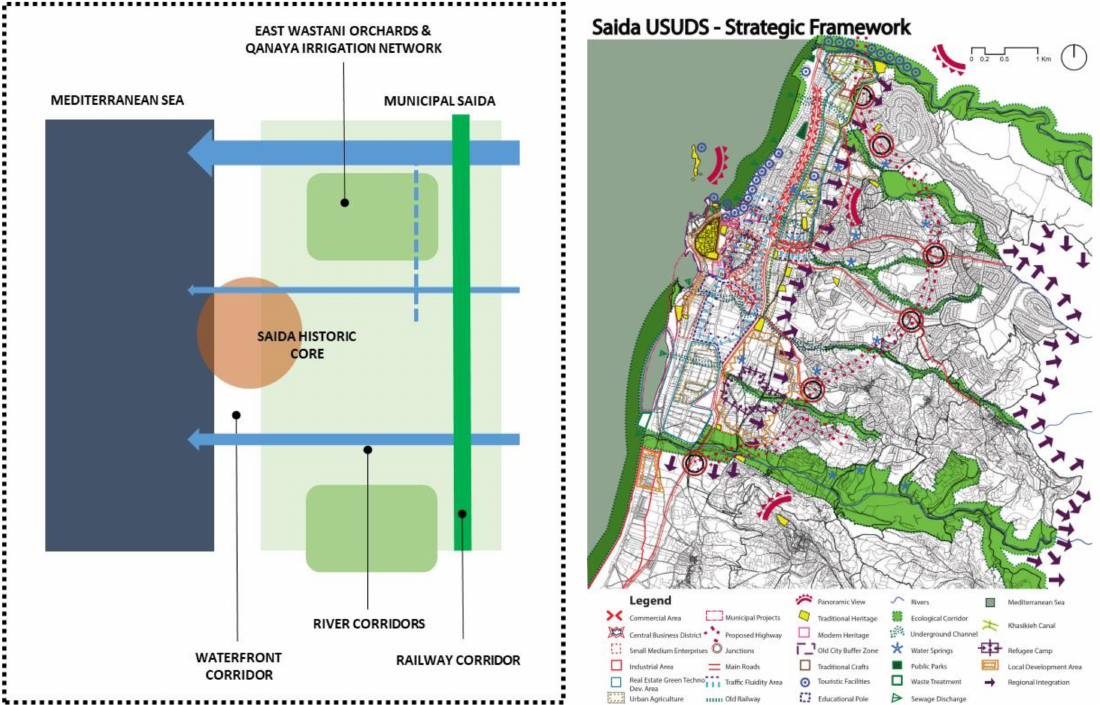
Figure 4. Saida USUDS landscape concept and consolidated structure plan embracing all five project disciplinary tracks